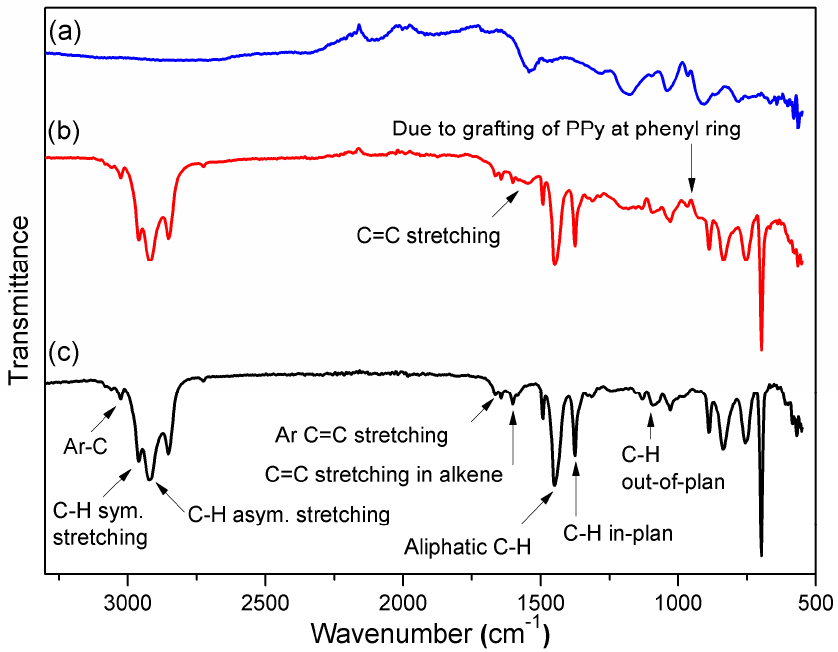
Figure 2. FTIR spectra of: ( a ) Pure polypyrrole (PPy); ( b ) 15 w / w % PPy / SIS Blends; ( c ) Pure poly (styrene-isoprene-styrene) (SIS).